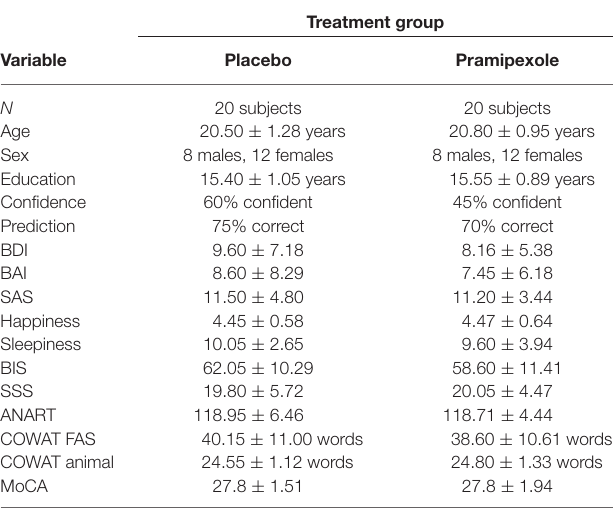
TABLE 1 | Demographic, cognitive and affective measures for healthy participants treated with either standard placebo or 0.5 mg pramipexole. Treatment